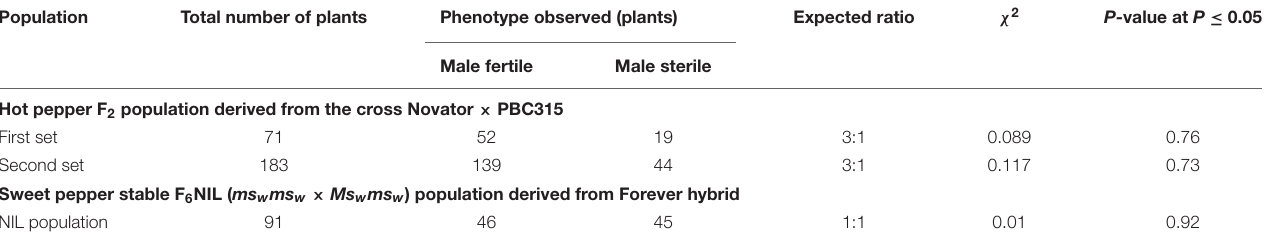
TABLE 1 | Segregation of male fertile and male sterile phenotypes in F 2 population of hot pepper and near isogenic lines population of sweet pepper. Population